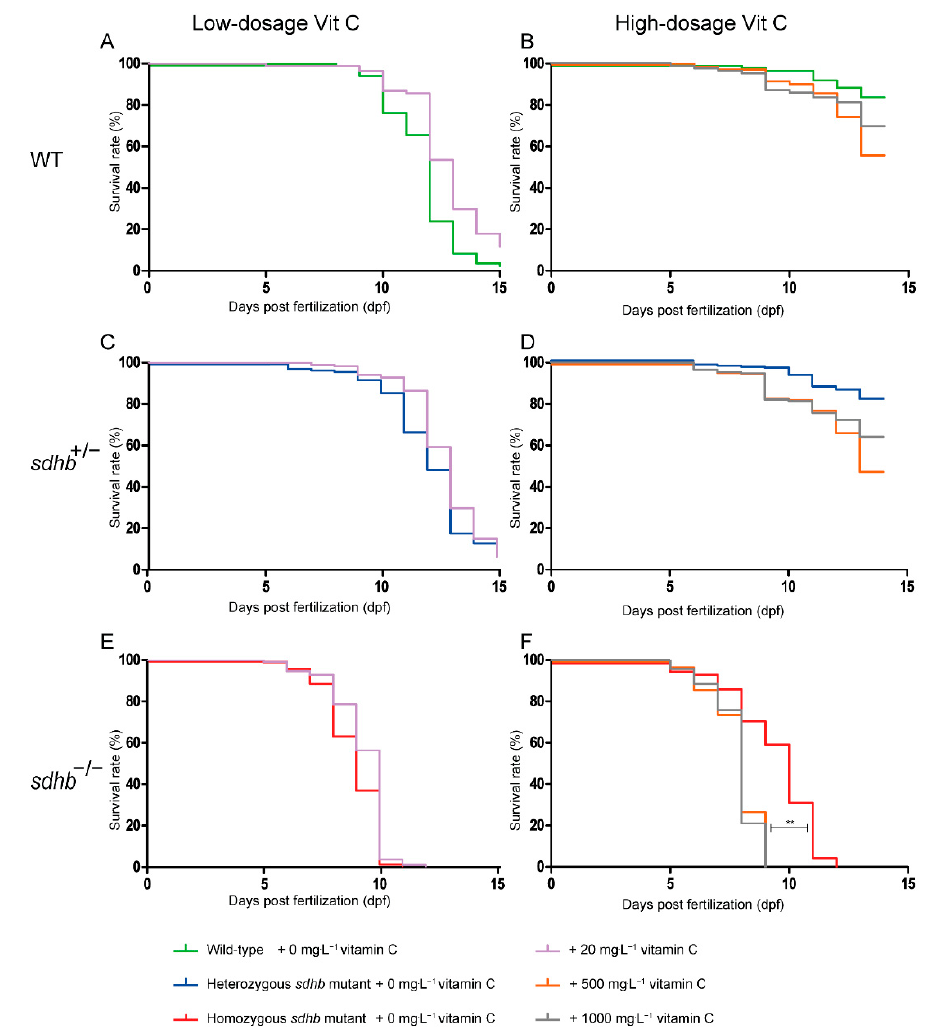
Figure 3. Survival in WT siblings ( A , B ), heterozygous sdhb mutants ( C , D ), and homozygous sdhb mutants ( E , F ) presented for control (0 mg ⋅ L − 1 green, blue, and red lines, respectively); low dosage (( A , C , E ) 20 mg ⋅ L − 1 , purple line) and high dosage (( B , D , F ) 500 mg ⋅ L − 1 , orange line; 1000 mg ⋅ L − 1 , grey line) Vitamin-C-treated larvae. ( A , C , E ) Survival rate (%) was not significantly prolonged after the low-dosage treatment of Vitamin C sdhb larvae compared to control (E3 medium supplemented; 0 mg ⋅ L − 1 ) larvae (control: n = 95 homozygous sdhb larvae, n = 126 heterozygous sdhb larvae, and n = 85 WT larvae; 20 mg ⋅ L − 1 Vitamin C: n = 112 homozygous sdhb larvae, n = 190 heterozygous sdhb larvae, and n = 91 WT larvae from two replicates). ( B , D , F ) Survival rate (%) was significantly reduced in homozygous sdhb mutants after treatment with high dosages of Vitamin C (500 and 1000 mg ⋅ L − 1 ) compared to control (E3 medium supplemented) larvae (control: n = 72 homozygous sdhb larvae, n = 198 heterozygous sdhb larvae, and n = 87 WT larvae; 500 mg ⋅ L − 1 Vitamin C: n = 84 homozygous sdhb larvae, n = 195 heterozygous sdhb larvae, and n = 70 WT larvae; 1000 mg ⋅ L − 1 Vitamin C: n = 90 homozygous sdhb larvae, n = 172 heterozygous sdhb larvae, and n = 86 WT larvae from two replicates). No significant differences were observed between sdhb heterozygous and WT siblings at either low or high dosage Vitamin C treatment. Log-rank (Mantel–Cox) test, ** p < 0.01.